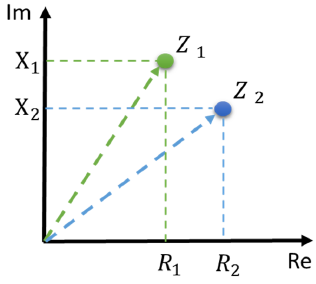
Figure 1. Work point in the complex impedance plane.